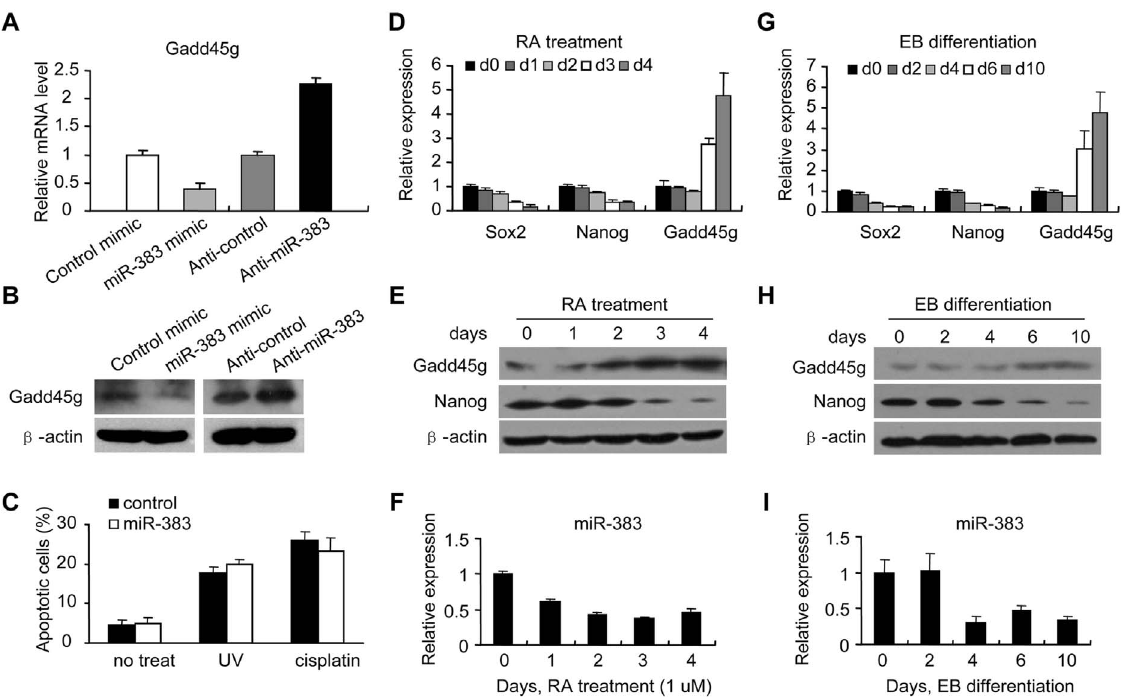
Figure 4. miR-383 regulates Gadd45g in mouse ES cells. (A) Relative mRNA expression of Gadd45g was measured by qRT-PCR in mouse ES cells (R1) transfected with miR-383 mimic or anti-miR-383. (B) Gadd45g protein levels were determined by western blotting in R1 cells. b -actin was used as a loading control. (C) R1 cells were transfected with miR-383 or control, followed by treatment with UV irradiation (50 J/m 2 , 12 h) or cisplatin treatment (10 m M, 24 h). The apoptosis was measured by Annexin V/PI staining. (D) Quantitative RT-PCR and (E) western blotting analysis were performed in ES cells and differentiated ES cells treated with RA (1 m M) for indicated days. (F) Quantitative RT-PCR data for miR-383 were performed in cells mentioned in (D), and normalized to the level of U6. (G) Quantitative RT-PCR and (H) western blotting analysis were performed in ES cells and cultured EB. (I) Quantitative RT- PCR data for miR-383 were performed in ES cells and cultured EB. In (D) and (G), data are expressed as relative expression compared with ES cells (set as 1.0). Values are means ¡ SD. In (E) and (H), b -actin was used as a loading control.